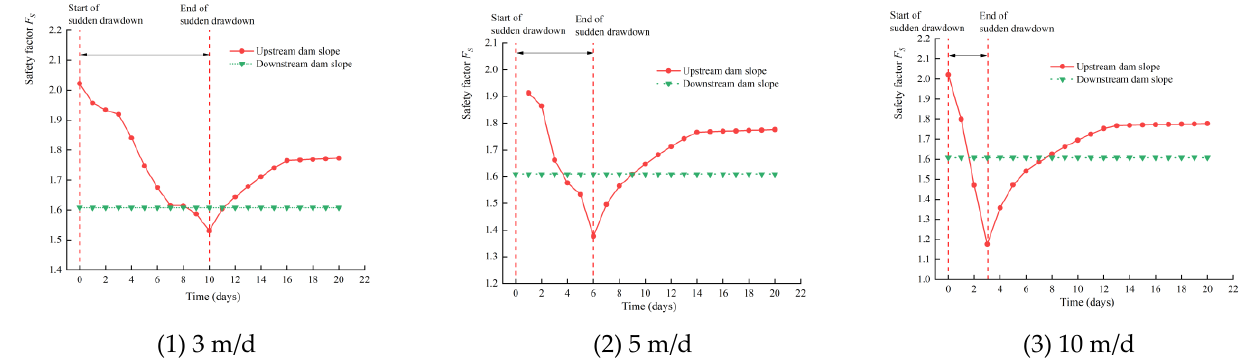
Figure 5. Duration curve of dam slope stability safety factor under different sudden drawdown speeds.